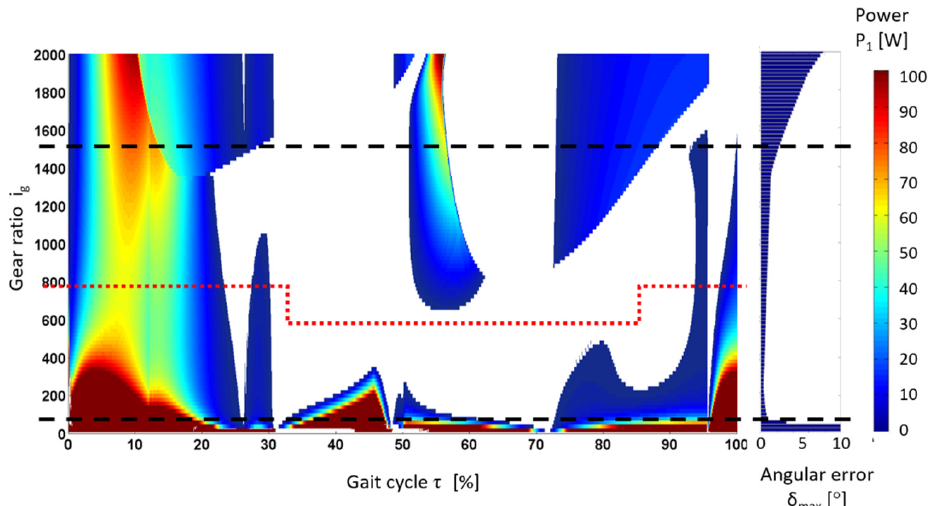
Figure 18. Graph of the instantaneous energy demand at the hip joint and the maximum profile error for the tested gear ratios when performing steps of 0.7 m.